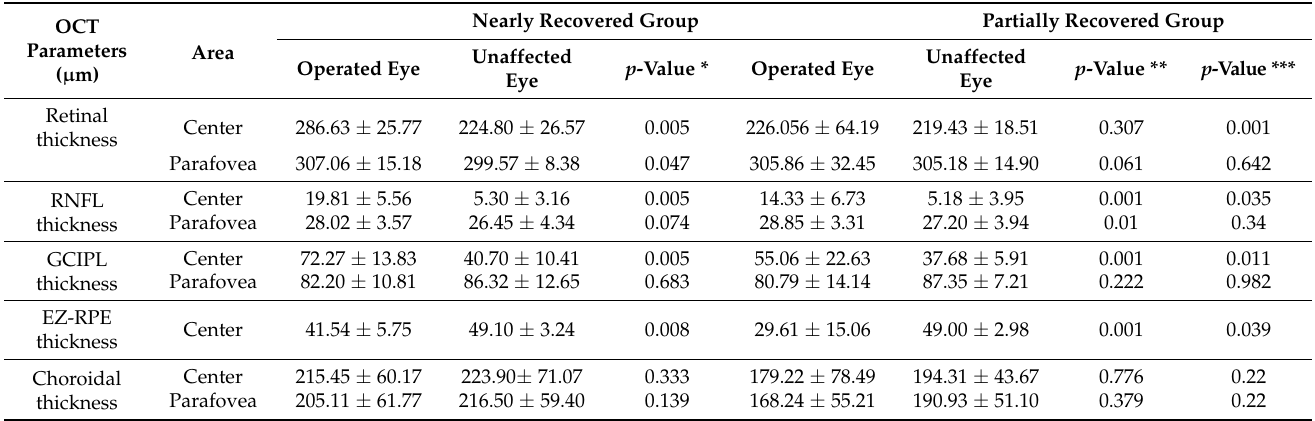
Table 3. Comparison between the retinal thickness of eyes with full thickness macular holes six months postoperatively and unaffected eyes.